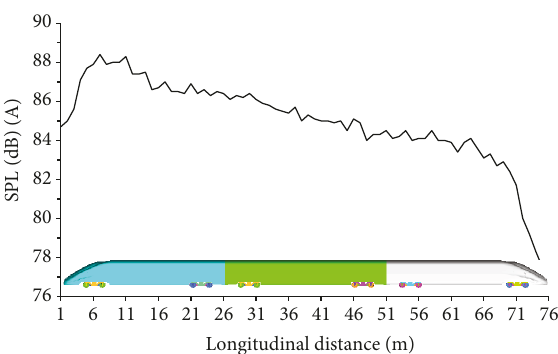
Figure 14: Distribution of noise levels of longitudinal noise bearing points.